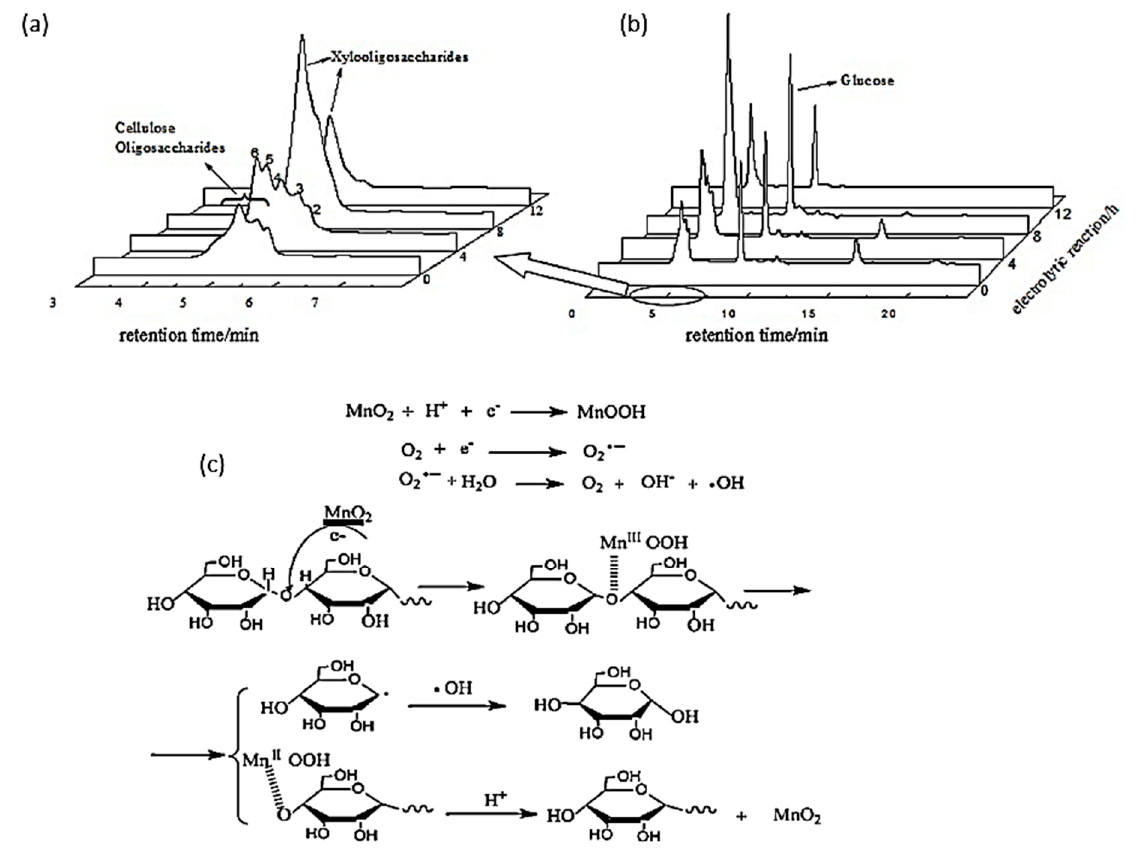
Figure 15. ( a ) HPLC of oligosaccharides after electrolysis. ( b ) HPLC of products after hydrothermal treatment of cellulose. ( c ) Proposed mechanism for cellulose oligosaccharide depolymerization with MnO 2 cathode. Reprinted with permission from Ref. [90]. Copyright 2014, Journal of Industrial and Engineering Chemistry.